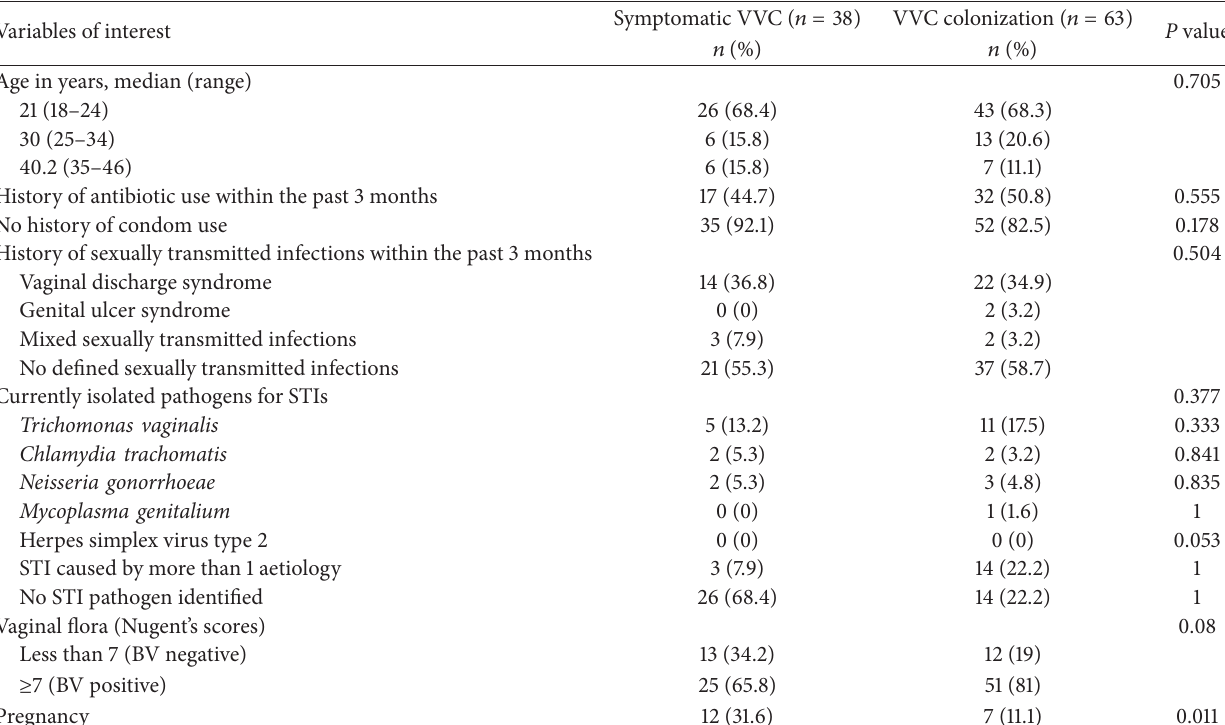
Table 4: Univariate associations between variables of interest and symptomatic vulvovaginal candidiasis (VVC) among HIV-uninfected women ( 𝑛 = 101